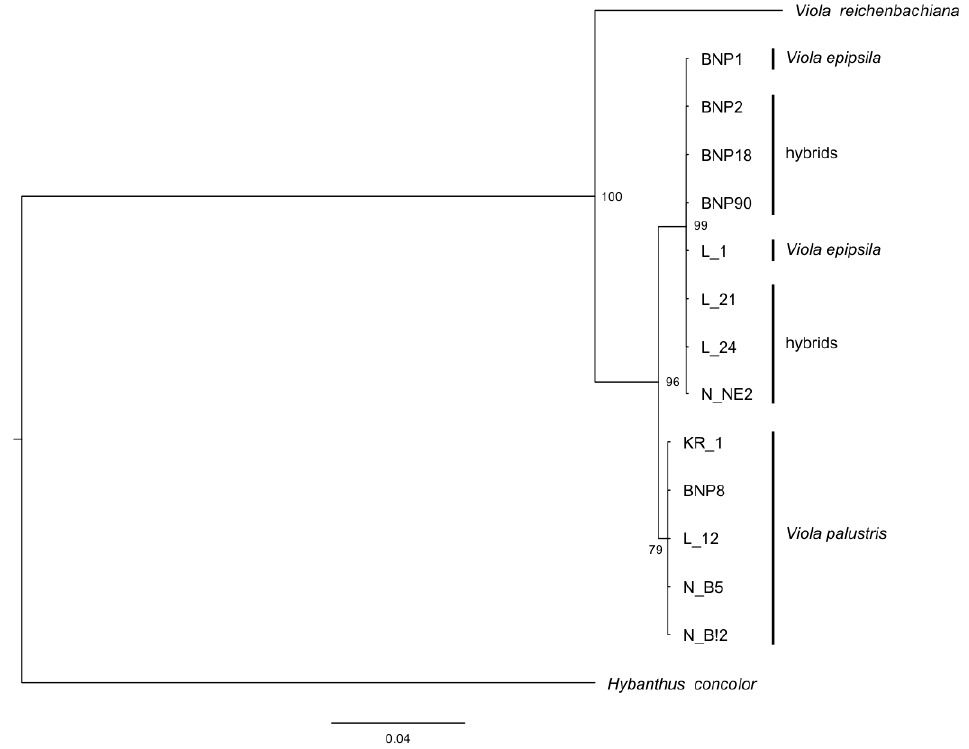
Figure 8. Rooted phylogenetic tree based on trnH-psbA and trnS-trnG intergenic spacers, inferred using Bayesian method. Node support values given are percentage of Bayesian posterior probabilities. Origin of samples: Germany (N), Poland (BNP, KR) and Lithuania (L). Detailed information in Table S1.